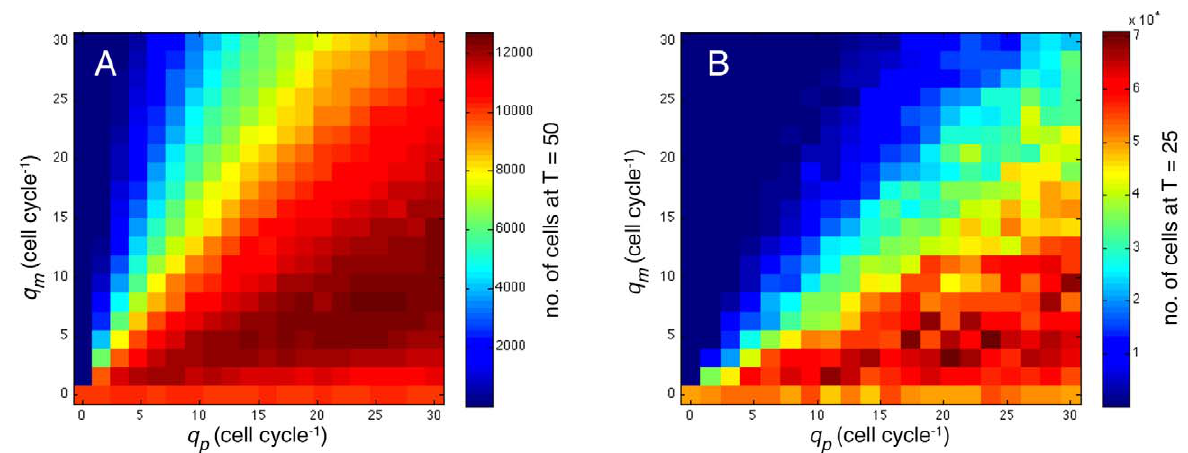
Figure 3. The impact of phenotypic switching rates on tumour mass. (a) The tumour mass at T ~ 50 for the 2-dimensional model as a function of the phenotypic switching rates q p (the rate at which cells become proliferative) and q m (the rate at which they become motile). (b) The tumour mass at T ~ 25 for the 3-dimensional as a function of q p and q m . The results in 2 and 3 dimensions are similar, although a larger variability seems to exists in the 3-dimensional case.